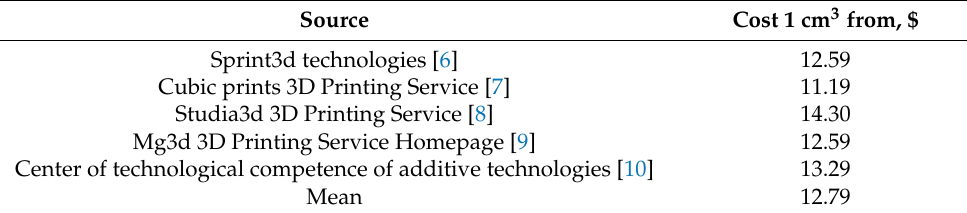
Table 1. Cost data for 3D printing stainless